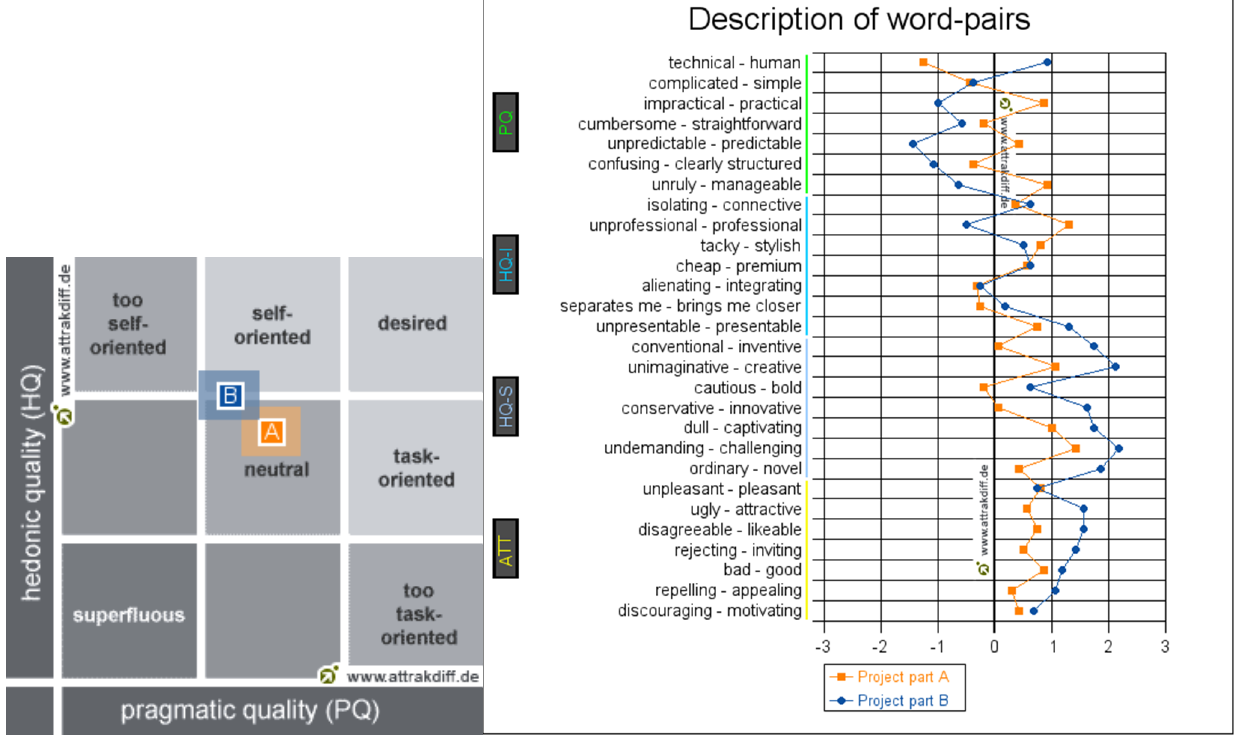
Figure 11. Overview of AttrakDiff results, with A being knobs on mDMI and B being the prototype